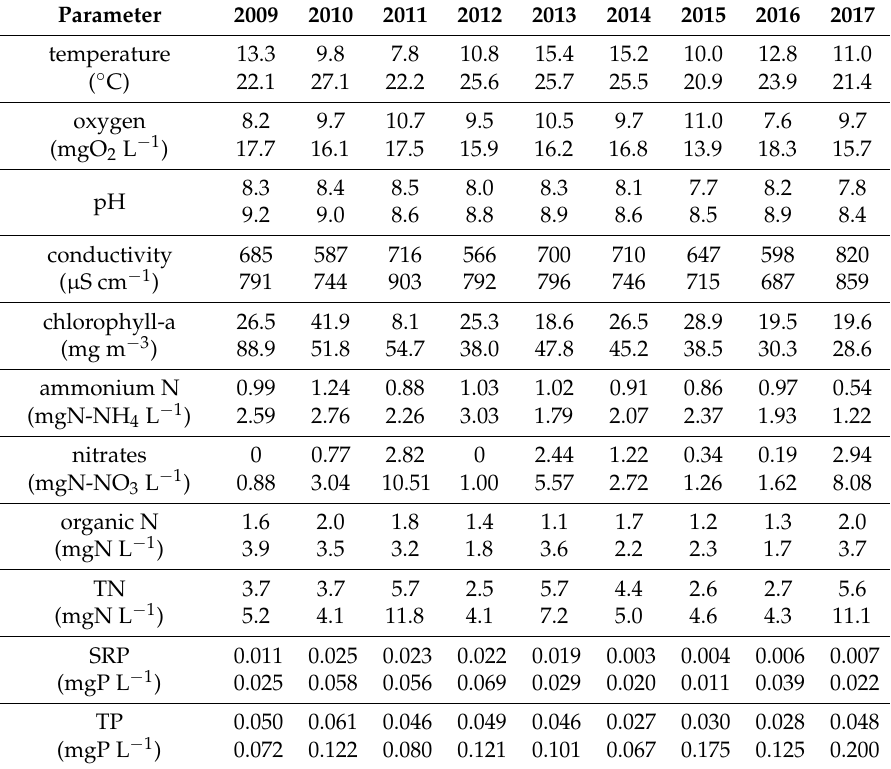
Table 2. The variability of medians and maximum values of water quality characteristics in the River Struga Gołaniecka flowing into Lake